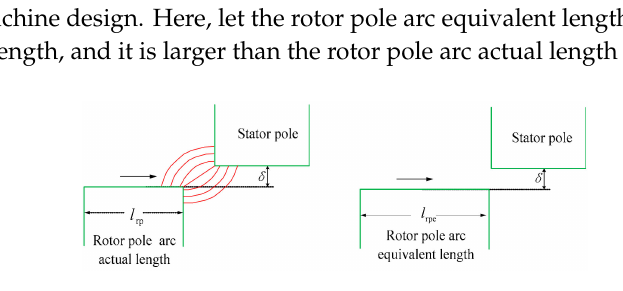
Figure 3. Rotor pole equivalent